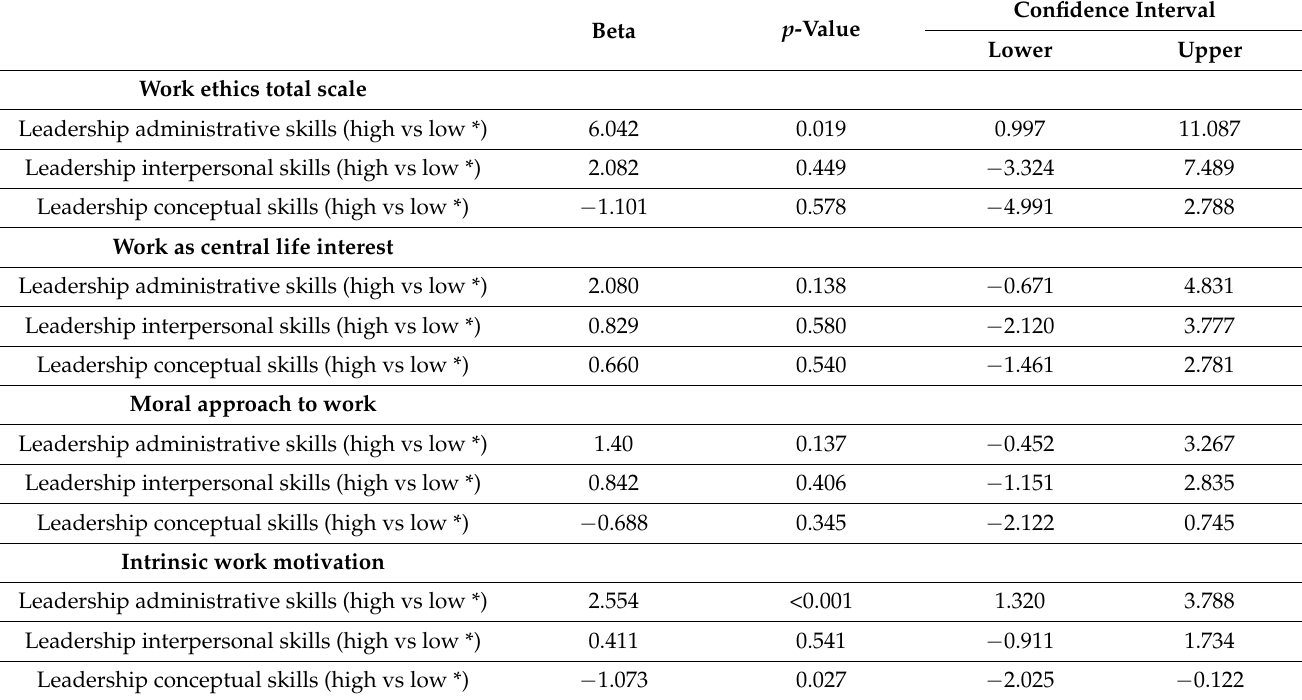
Table 4. Multivariable analysis of covariance